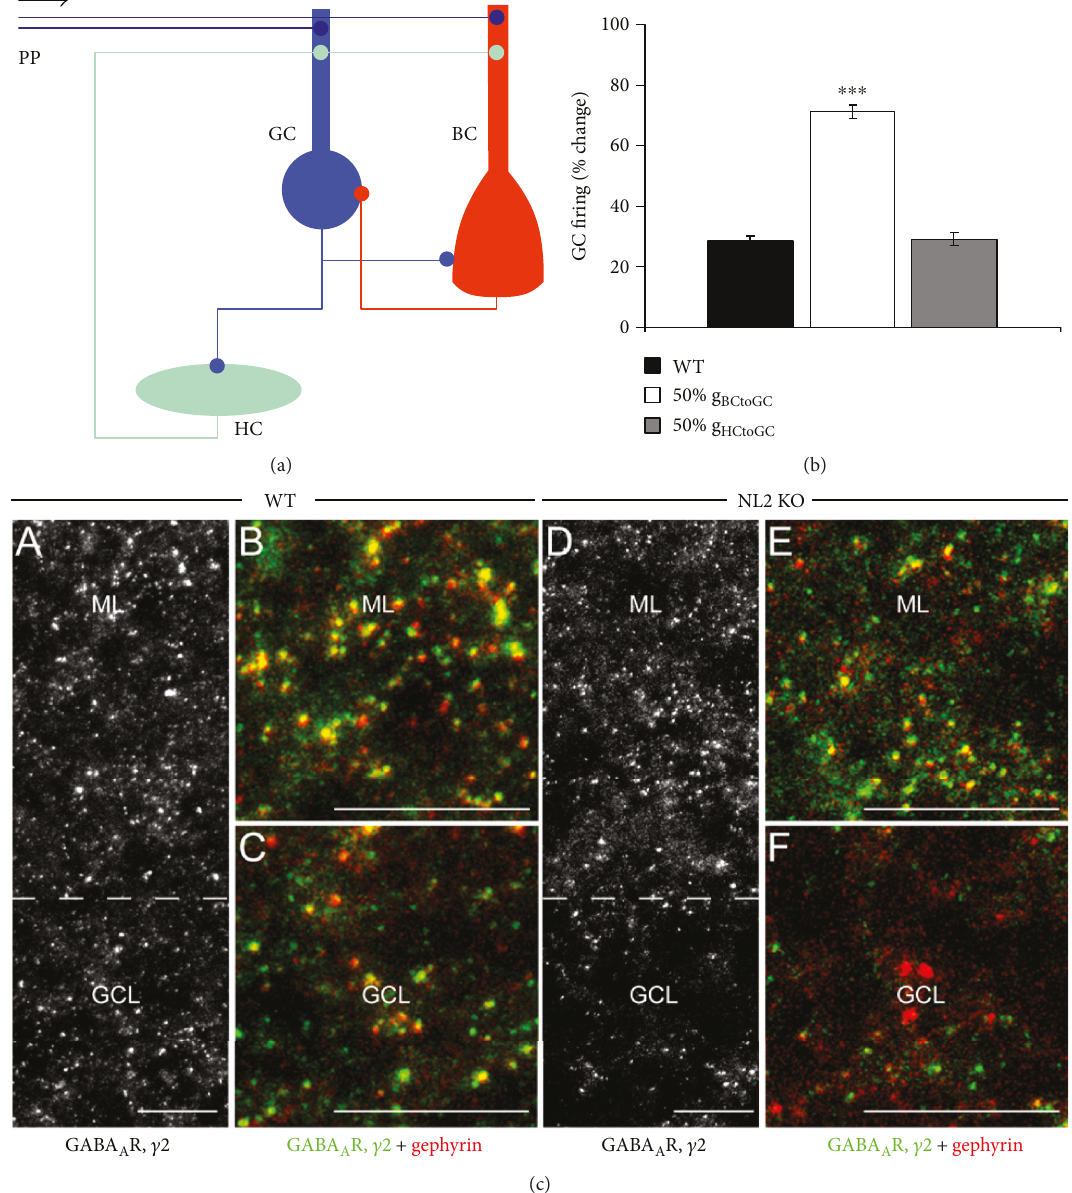
Figure 4: Biologically detailed network modelling predicted that reduced paired-pulse inhibition of granule cell fi ring observed in NL2 KO mice was due to the reduction of somatic GABAergic inhibition mediated by basket cell synapses. (a) Schematic circuit depicting connections among excitatory granule cells (GC) and inhibitory basket cells (BC) and hilar cells (HC) in the network model [62]; mossy cells (MC) not shown). (b) Quanti fi cation of simulation data on network inhibition of granule cell fi ring. Network inhibition is weaker and GC fi ring is signi fi cantly higher ( t -test, ∗∗∗ p < 0 001 ) in the simulated NL2 KO network model with reduced GABA conductance A (50% reduction of maximum synaptic conductance) at somatic (BC-to-GC) inhibitory synapses (g ). Note that no signi fi cant BCtoGC impairment of GC network inhibition was observed in the network model with a selective reduction (50%) of GABA synaptic A conductances at dendritic HC-GC synapses (g ). (c) The punctate immunostaining of sections from WT (A-C) and NL2 KO mice HCtoGC receptors and inhibitory postsynaptic marker gephyrin. Modelling predicted and experiments (D – F) for γ 2-subunit of GABA A con fi rmed that diminished network inhibition of GC fi ring, found in electrophysiological recordings in NL2 KO animals, was accompanied by a reduction of somatic GABA receptor clusters in the granule cell layer (GCL) of the dentate gyrus. Note that the A number of GABA receptor clusters located in the dendritic molecular layer (ML) of the dentate gyrus was not changed in NL2 KO A animals. Also, the colocalization of GABA receptor γ 2-subunit and gephyrin was selectively reduced in the GCL but not in the ML of A NL2 KO mice (adapted with permission from